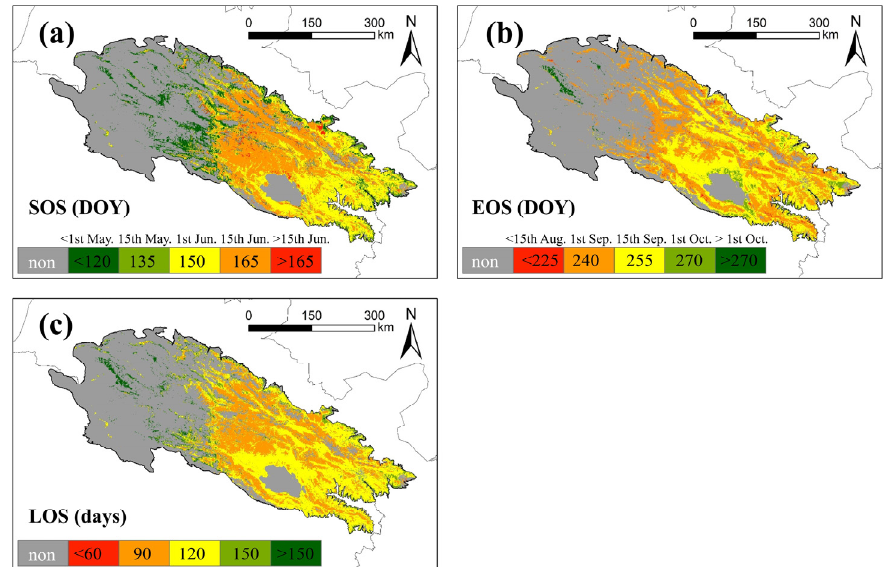
Figure 7. Mean of land surface phenology metrics in QLMA from 2003 to 2021. ( a ) represents the SOS, ( b ) represents the EOS and ( c ) represents the LOS.